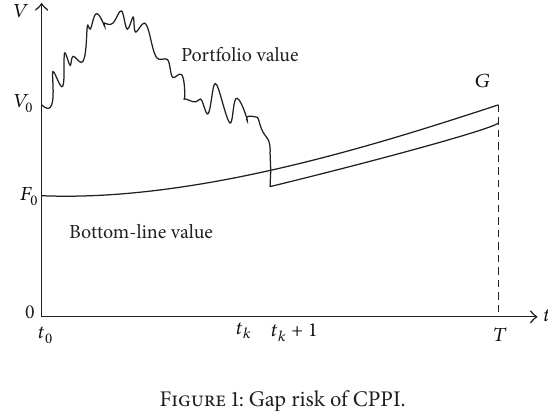
Figure 1: Gap risk of